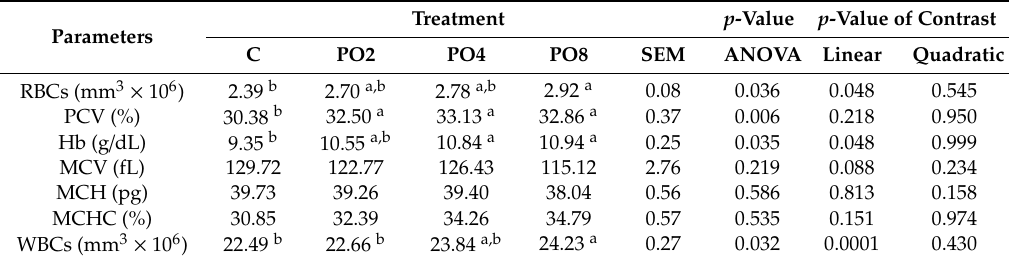
Table 3. Haematological blood indicators of broilers fed with di ff erent supplementation doses of POLM at day 21.